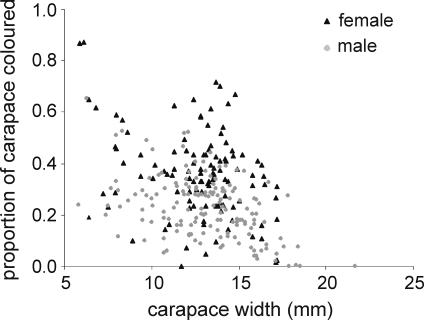
Correlation of colour area and carapace size in male and female Uca capricornis.(a) Females are more coloured than males of a similar size, but both sexes become less coloured as they grow. Females n = 115, males n = 158.